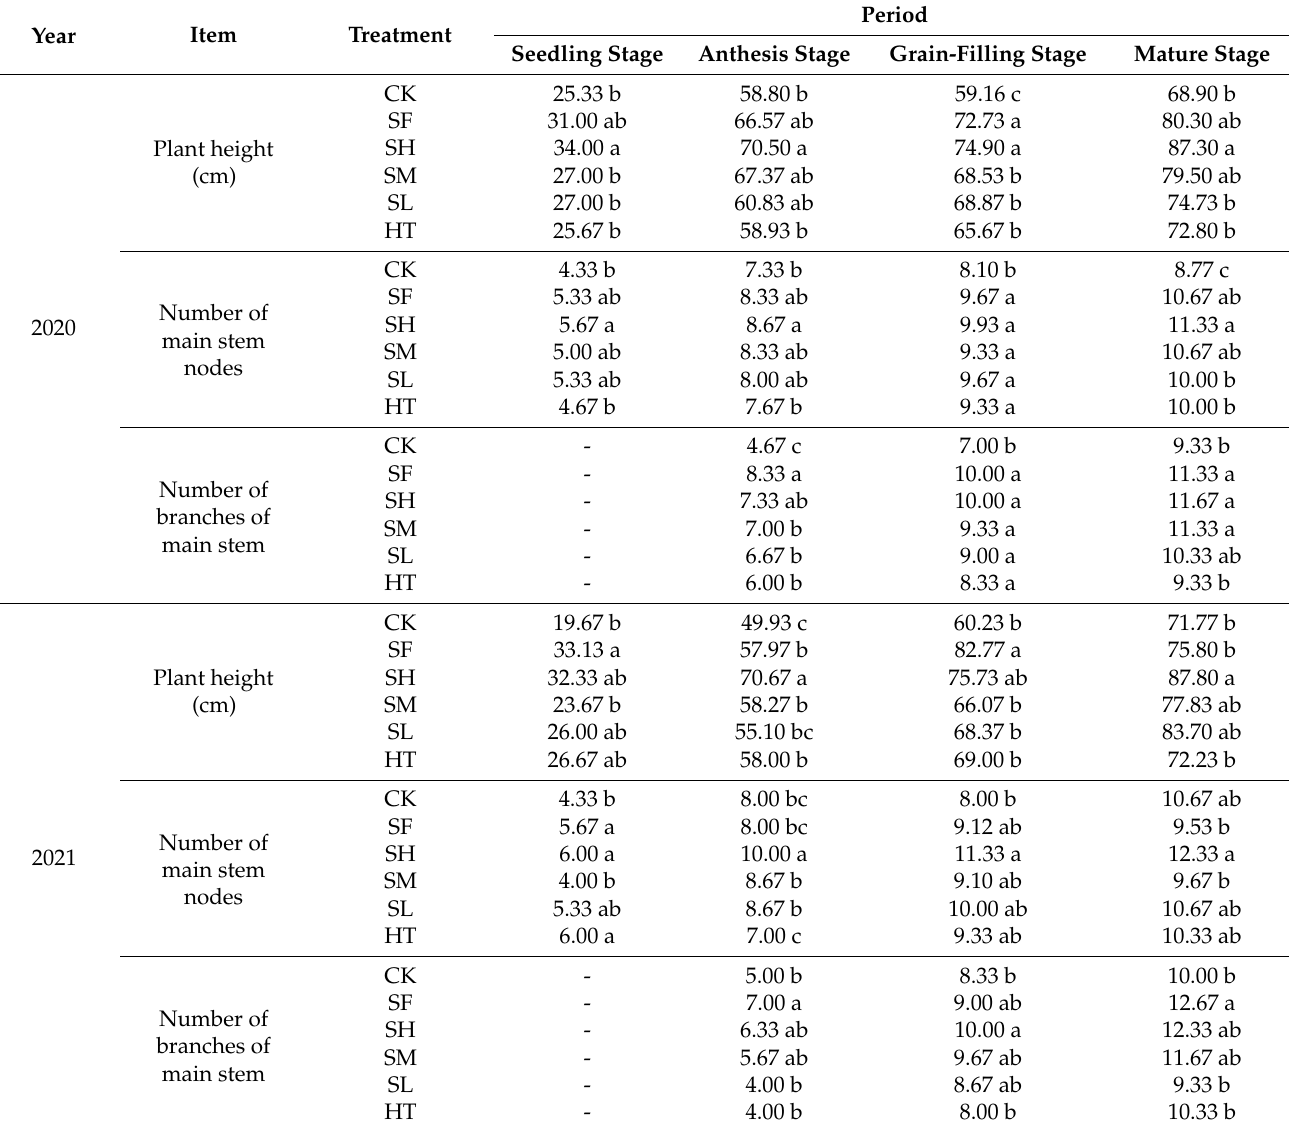
Table 6. Effect of rice straw combined with inorganic fertilizer on agronomic